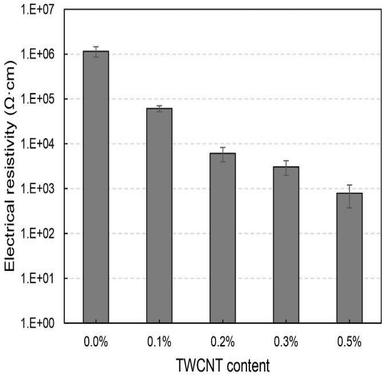
Electrical resistivity values of samples.